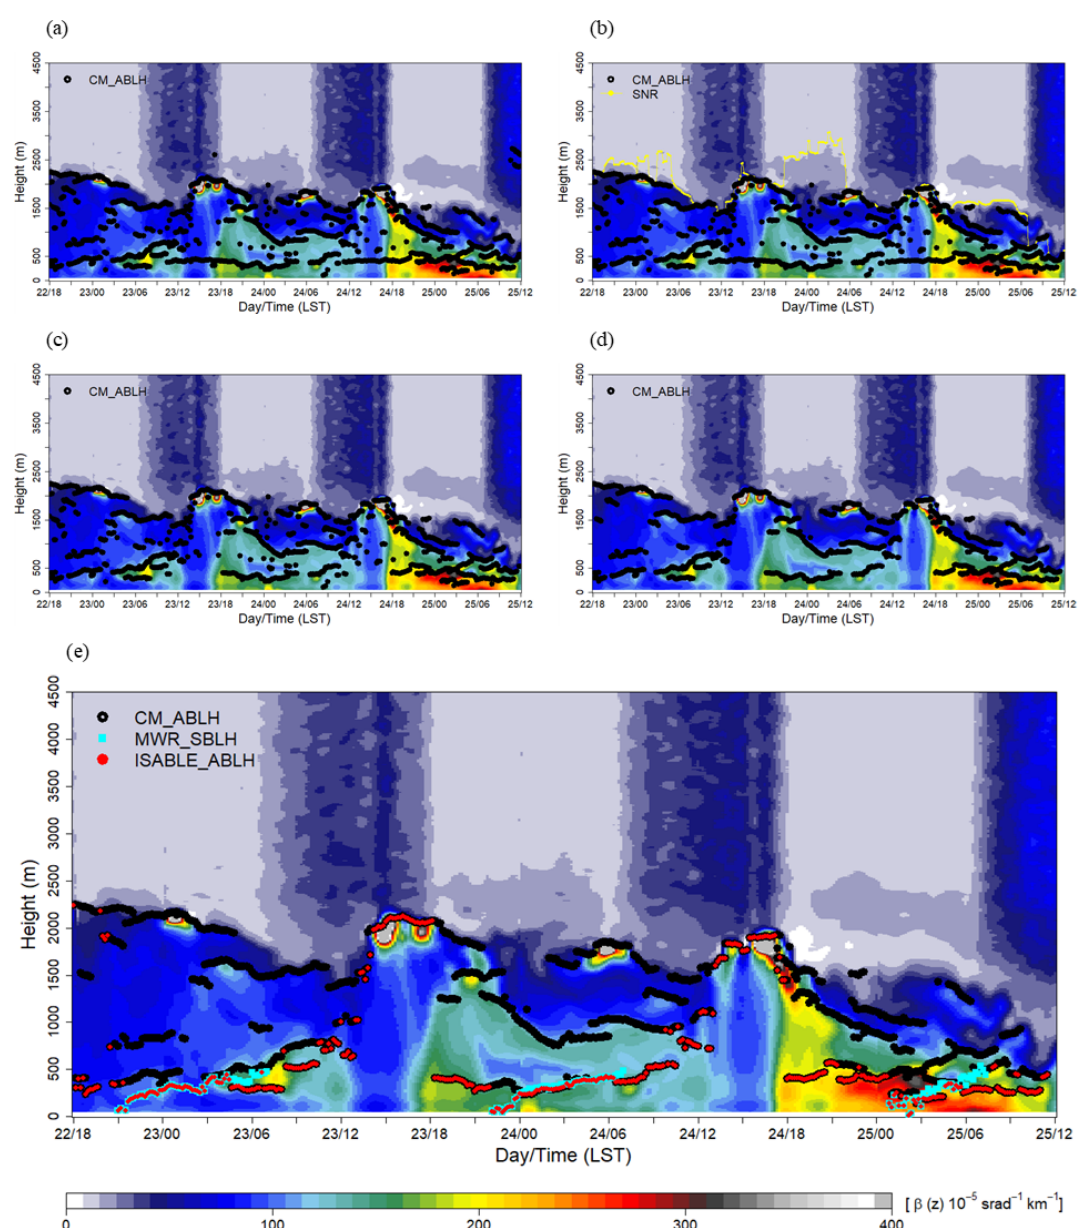
Figure 7. Post-processing steps for determining the ABLH by ISABLE (ISABLE_ABLH): (a) time series of the ABLH (CM_ABLH) without quality control; (b) applying h SNR threshold height and eliminating unreasonable values near the lens of the ceilometer; (c) removing isolated ABLH using temporal discontinuity and DBSCAN; (d) the SBLHs estimated via microwave radiometer (MWR_SBLH) were merged and then post-processing was applied; (e) final ABLHs were used to determine the lowest